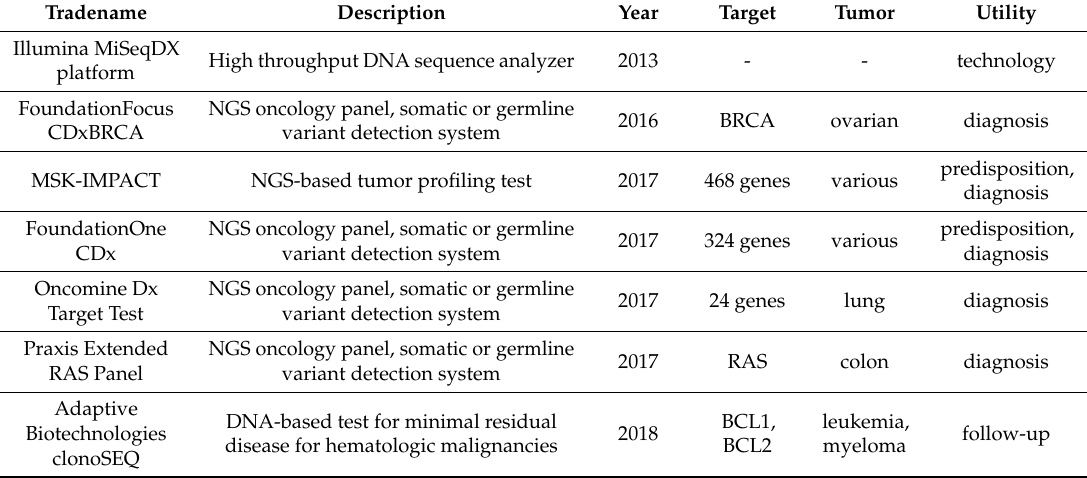
Table 4. Food and Drug Administration (FDA)-approved next-generation sequencing (NGS)-based methods suitable for cancer predisposition identification, cancer detection, or